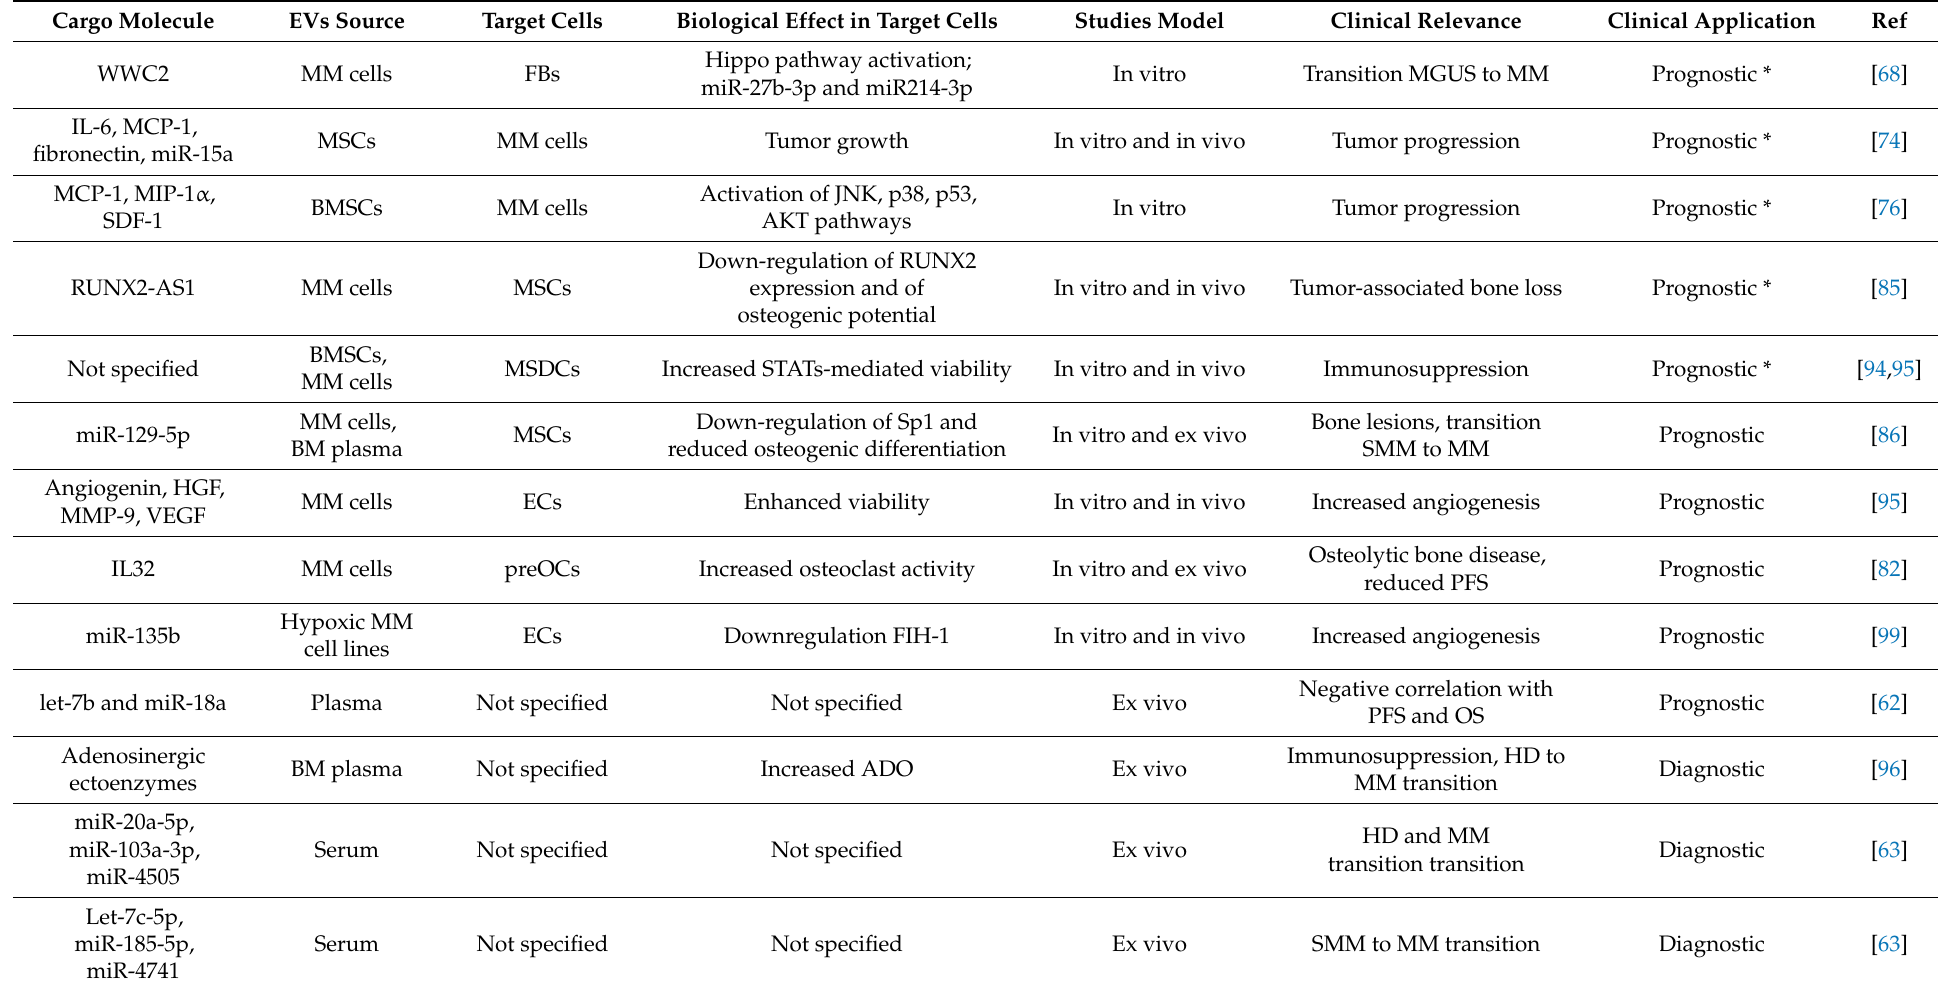
Table 1. Biological and clinical relevance of role of EVs in